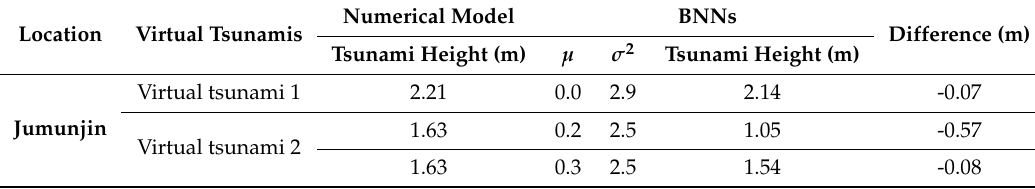
Figure 13. Time series of tsunami heights at epicenter by ( a ) virtual tsunami 1 and ( b ) virtual tsunami 2. Table 3. Comparison of numerical model and BNNs for predicted maximum tsunami heights at gage in Jumunjin port over virtual tsunamis in